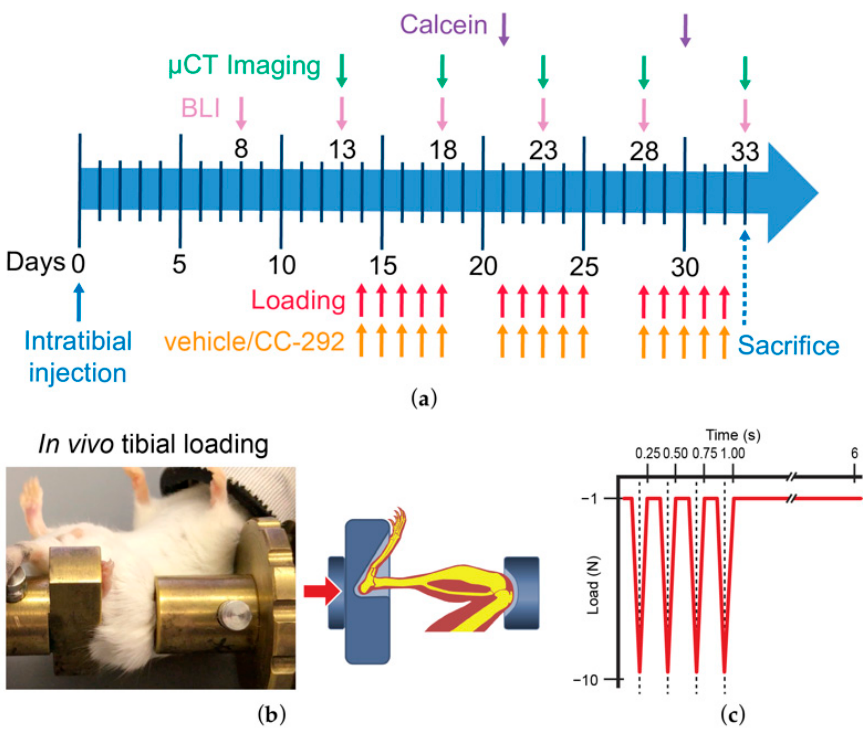
Figure 1. Overview of the loading experiment. ( a ) The experimental timeline. Mice were injected with MOPC315.BM.Luc cells on day 0; after 8 days, bioluminescence imaging (BLI) started; on day 13, microCT imaging started; on day 14, the loading regime and the vehicle and CC-292 oral treatment began; mice were sacrificed on the last microCT day, day 33. ( b ) Balb/c mouse undergoing loading. The knee and the ankle are fixated and loading is applied. The head lies in an anesthetic mask, through which oxygen and isoflurane are supplied. ( c ) Schematic overview of the applied loading cycles. Four peak loads of − 10 N were applied using a 4 Hz frequency, after which a 5 s pause was inserted. Then, the cycle started anew. Cycles were repeated 216 times a day, which lasted approximately 5 min. After MM injection, bioluminescence imaging (BLI) signals in all mice were detected already at day 8 and local tumor growth was confirmed (data not shown). MicroCT three-dimensional (3D) renderings of MM-injected tibiae at day 13 compared to day 33 revealed an increase in the number and size of osteolytic cortical lesions in all nonloaded mice (Figure 2a,b, left panels). Quantification of in vivo microCT cortical microstructural parameters at the metaphyseal region shows changes over the experimental period ( ∆ between day 13 and day 33, Figure 3a,b, Supplementary Tables S1 and S2), that reflect the osteolytic potential of the MOPC315.BM.Luc cells in young animals that are still growing. BLI signals showed a similar increase in vehicle (circles) and CC-292 (squares) treated nonloaded mice until day 28 (Figure 4). Between day 28 and day 33, BLI signals in- creased 2.7-fold in the vehicle treated and 1.8-fold in the CC-292 treated nonloaded mice (Figure 4). By day 33, vehicle and CC-292 treated nonloaded mice showed a similar degree of cortical destruction based on 3D renderings (Figure 2a,b, left panels). Changes in cortical thickness (Ct.Th) and cortical porosity (Ct.Po%) between day 13 and day 33 were not different between nonloaded vehicle treated and nonloaded CC-292 treated mice.